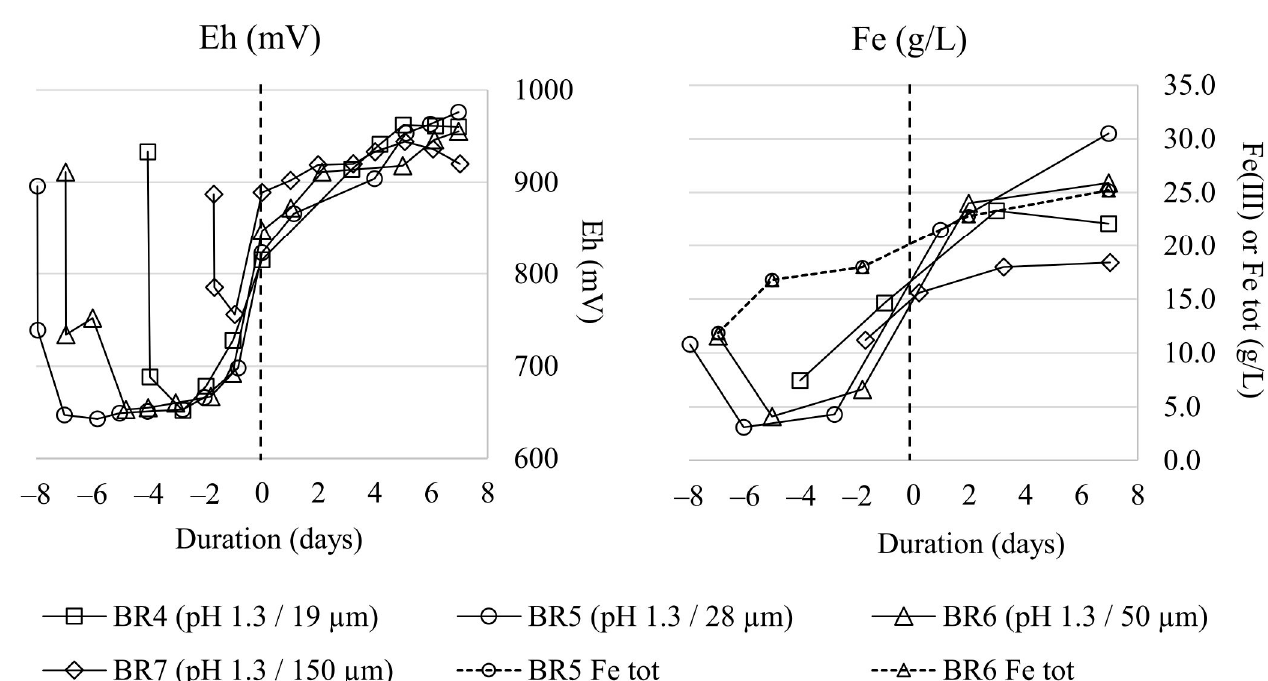
Figure 2. Evolution of Eh, Fe(III) and total acid dissolving Fe concentration (only for BR5 and BR6) in bioleaching reactors with different sulfide concentrate particle sizes (d80 < µ m). The dashed vertical line illustrates the starting point of 7-day bioleaching tests. The negative days illustrate the length of ramp-up phase. Table 6. The acid and base consumption in bioleaching tests, normalized to 95% H 2 SO 4 and pure 100% CaCO 3 use per kg of feed